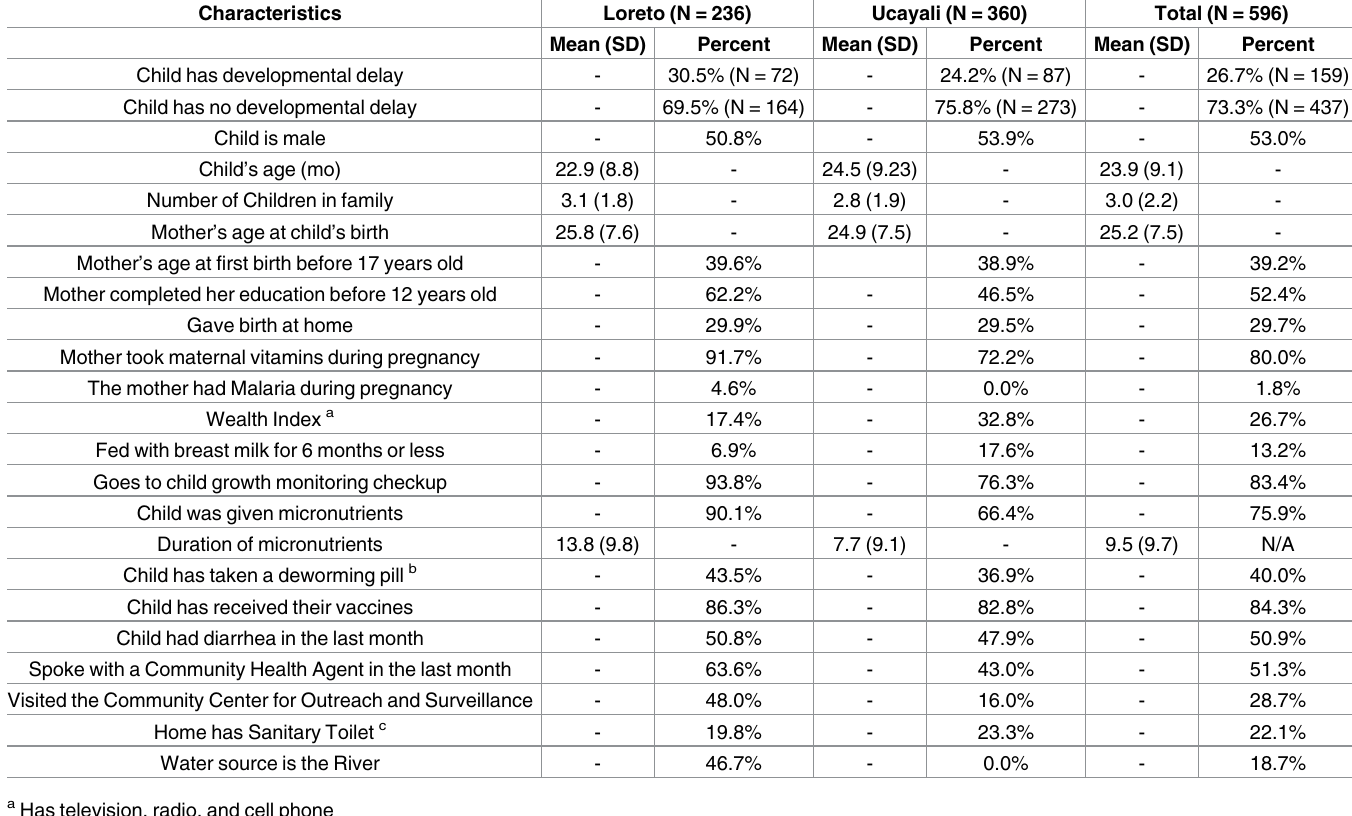
Table 2. Descriptivestatistics of study population, by